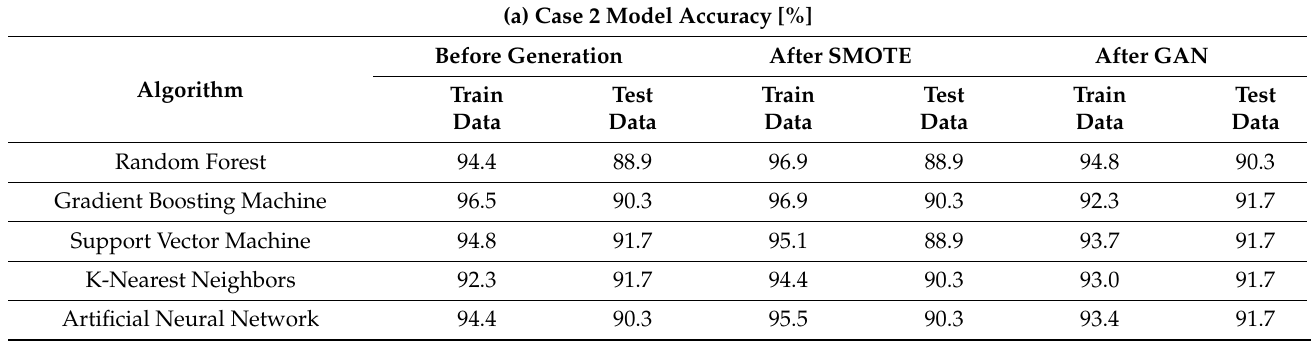
Table 3. Fault detection model performance with Case 2; ( a ) model accuracy with training data and test data and ( b ) model performance with test